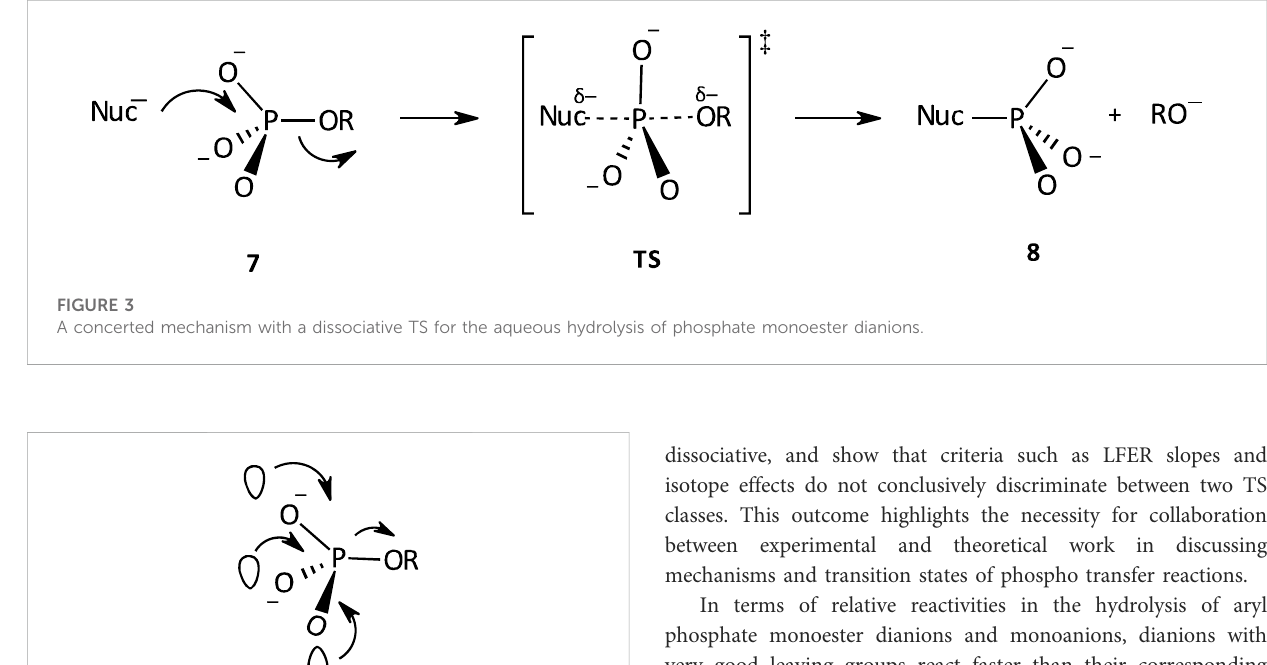
FIGURE 4 An illustration of the multiple n- σ * P-O interactions which assist